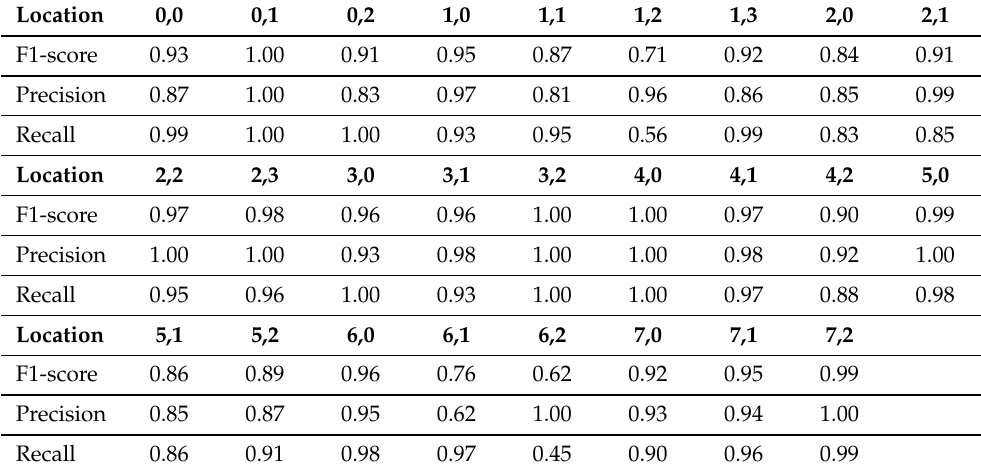
Figure 20. Features generated by the Flatten input block for all 26 locations. One color is assigned for feature datapoints coming from the same location (label). Table 9. Confusion matrix for the classifier using information coming from all 26